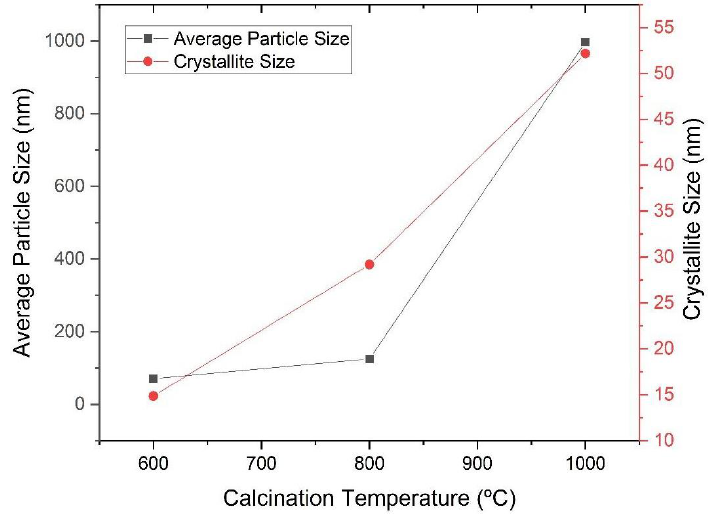
Figure 8. Average particle size (DBET) and crystallite size as a function of the calcination temperature of the powders obtained via sol-gel and heat-treated at different temperatures (600 °C, 800 °C and 1000 °C). The micrographs (Figure 9) show that the powders obtained by the sol-gel method showed large clusters and/or aggregates, with a dense appearance and irregular sizes. In all samples, rods with sizes larger than the predominant particulates (BaTiO 3 ) with rounded shapes were not observed. These rods are characteristic of BaCO 3 [13].